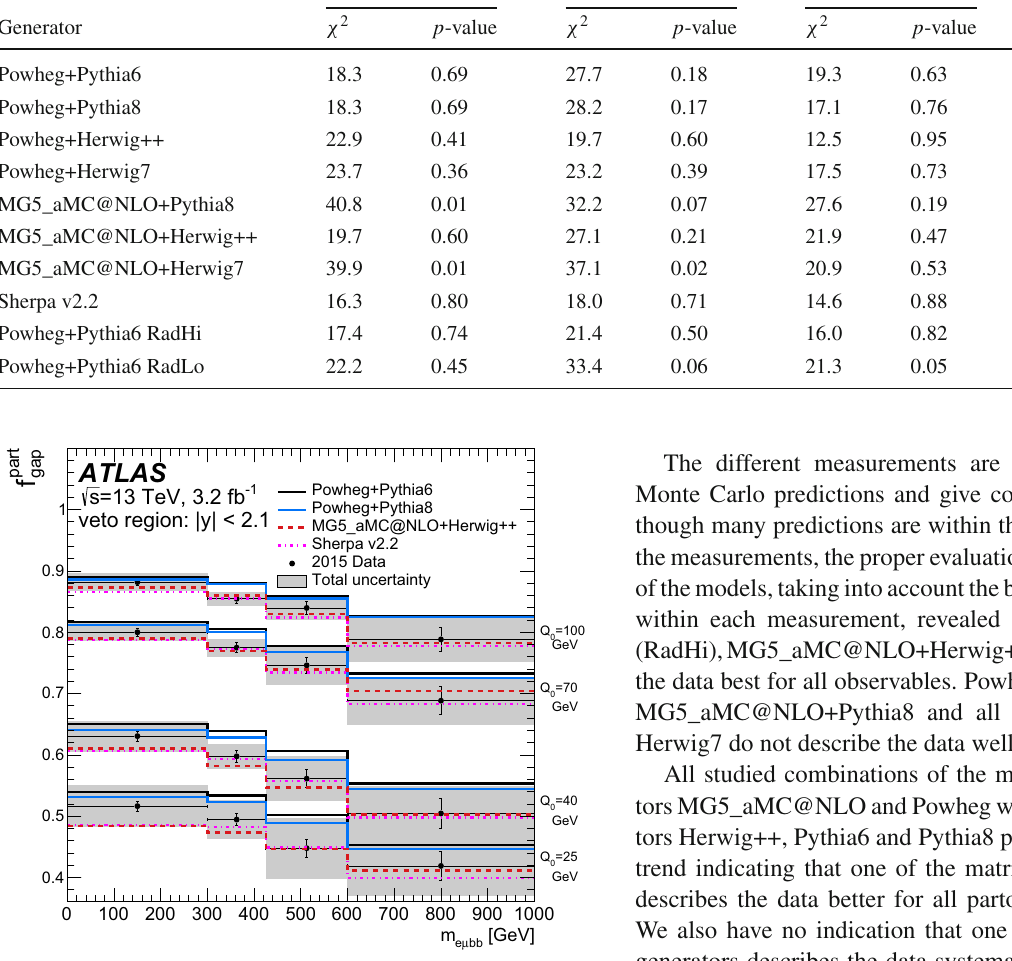
Table 15 Measurements of χ 2 comparing the measured gap fraction distributions with predictions from various t ¯ t generator configurations, for the four invariant mass m e μ bb regions as a function of Q sum . The χ 2 and p -values correspond to 22 degrees of freedom Q sum